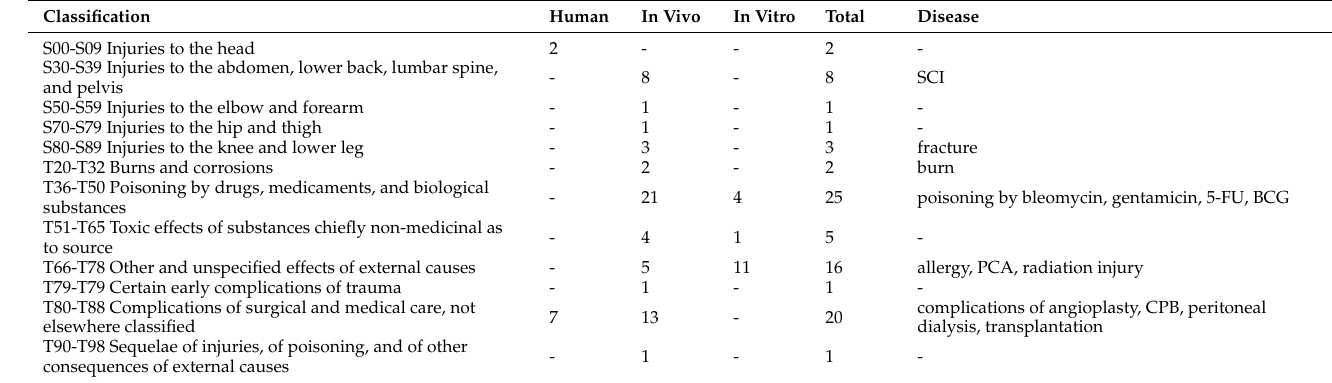
Table 6. The statistics of pharmacological results and its major diseases of SMC by experimental type in XIX Injury, poisoning, and certain other consequences of external causes of